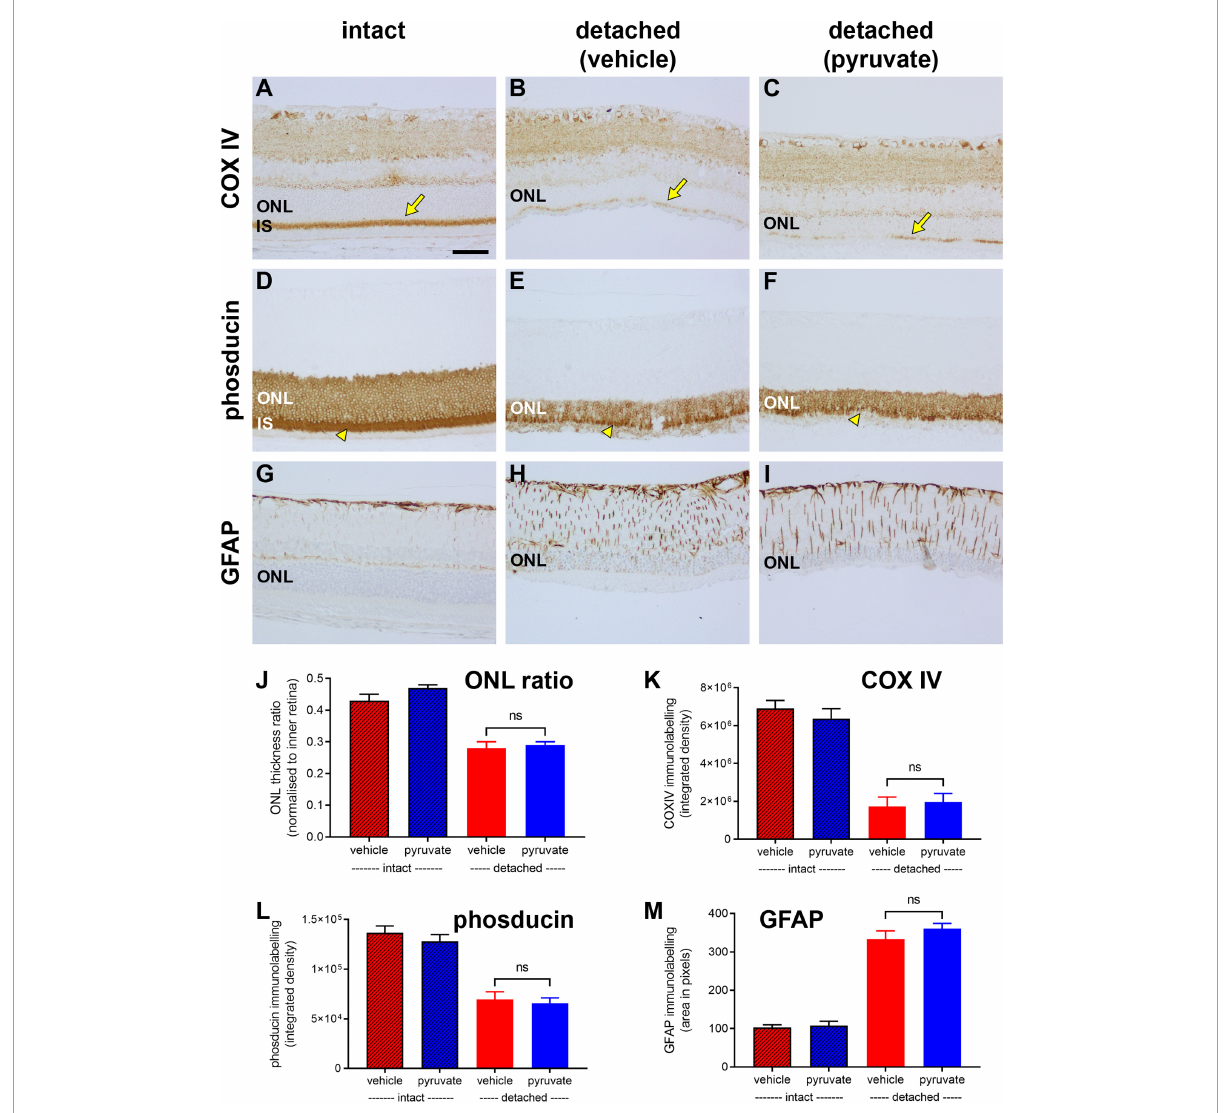
FIGURE12 Long-term pyruvate supplementation fails to protect against photoreceptor degenerative changes at 4 weeks after retinal detachment. (A–I) Representative images of COX IV (arrows highlight inner segments, IS), phosducin, and GFAP immunoreactivites in intact retina (A,D,G) , and at 4 weeks after detachment in rats administered normal (B,E,H) or pyruvate-supplemented (C,F,I) drinking water. Scale bar: 60 µ m. ONL, outer nuclear layer. (J–M) Quantification of ONL thickness ratio (J) , abundance of COX IV immunoreactivity associated with IS (K) , abundance of phosducin immunoreactivity (L) , and total area of GFAP immunolabelling (M) . All values represent mean ±